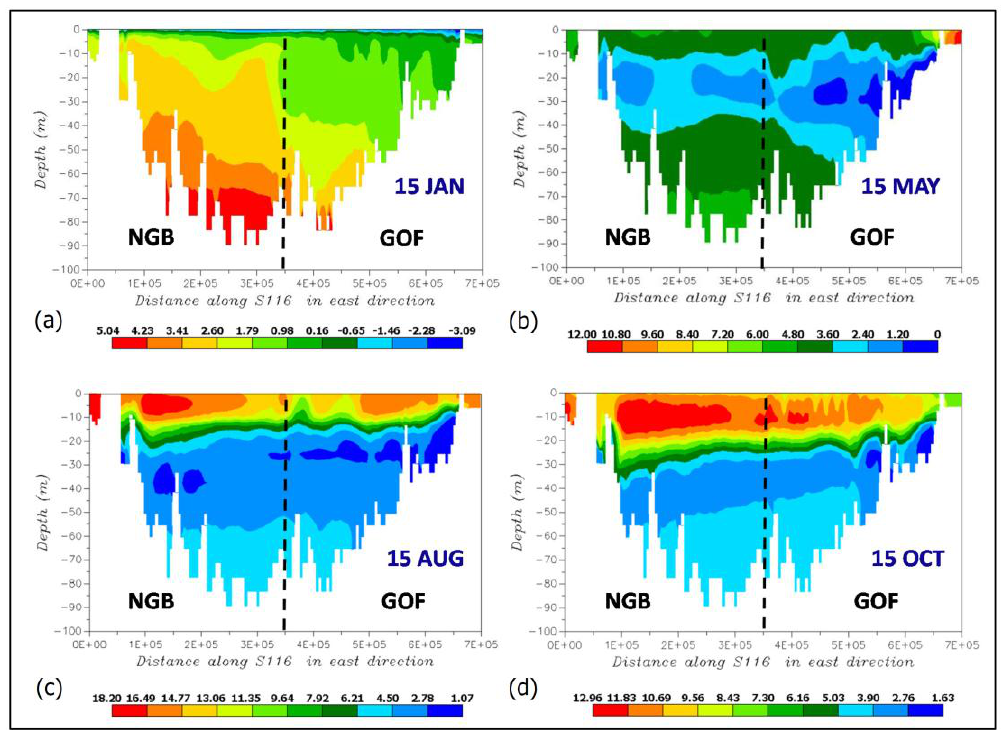
Figure 14. Seasonal thermal stratification plots in the Baltic Sea at cross section S116 for the year 2000. ( a ) Winter; ( b ) Spring; ( c ) Summer; ( d ) Autumn. The temperature development at the Baltic Sea is affected by the intrusion of the warmer water masses from the North Sea and cold low salinity river water masses that flow into the Bay of Bothnia. The northern part of the Baltic Sea is covered by ice during winter and spring, which